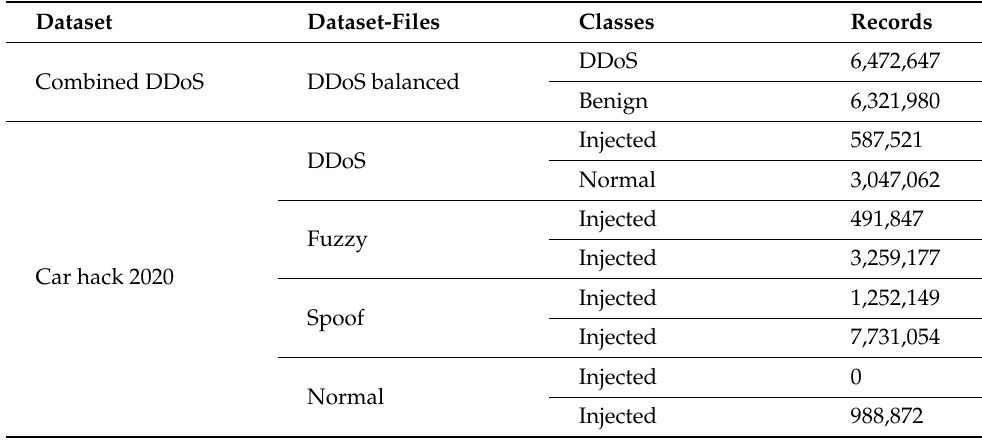
Table 3. The utilized